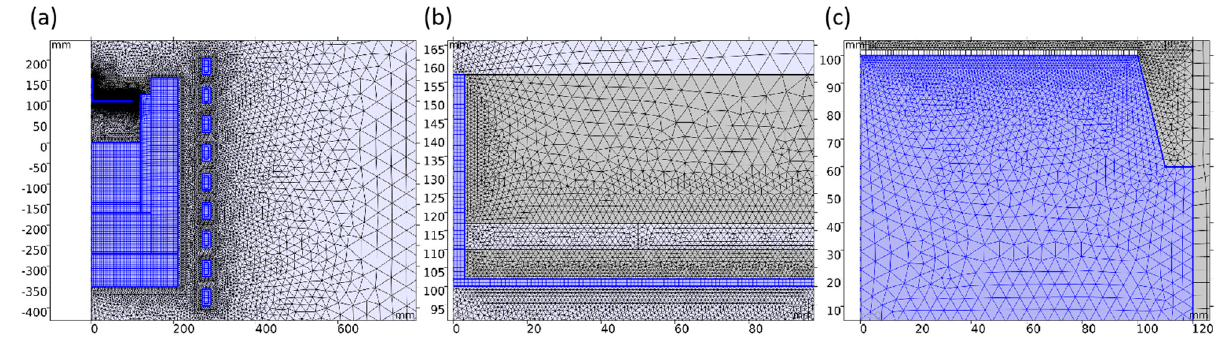
Figure 2. Generated grids. ( a ) Thermal field; ( b ) seed crystal and view tube; ( c ) growth chamber. Table 3. Control parameters and quality of the generated mesh.